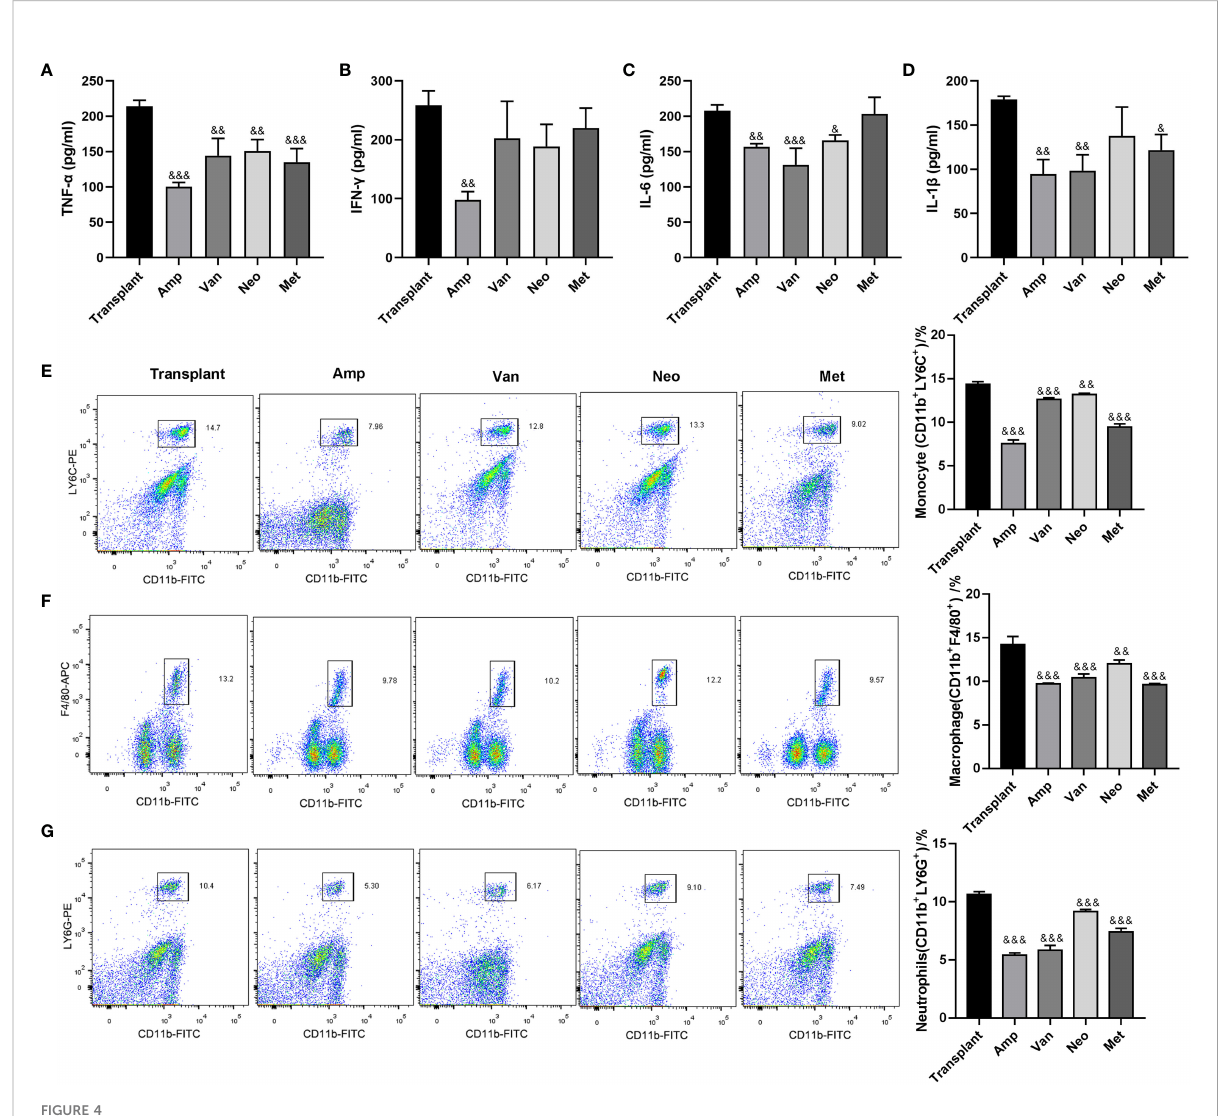
FIGURE 4 Effect of single antibiotic on in fl ammatory response in renal transplantation mice. (A-D) ELISA was used to detect the expression levels of TNF- a 、 IFN- g 、 IL-6 and IL-1 b in the transplanted renal. (E-G) Flow cytometry used to detect the in fi ltration of in fl ammatory cells (monocytes, macrophages, neutrophils) in the transplanted renal. & p < 0.05, && p < 0.01, &&& p < 0.001 vs transplant